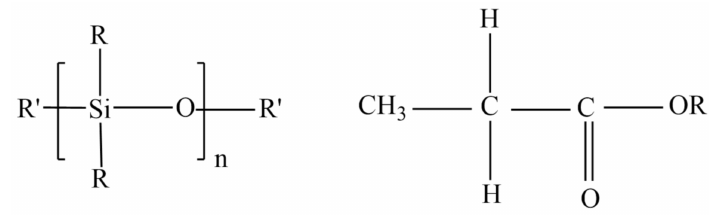
Figure 2. Chemical structure of Polymethyltriethoxysilane.